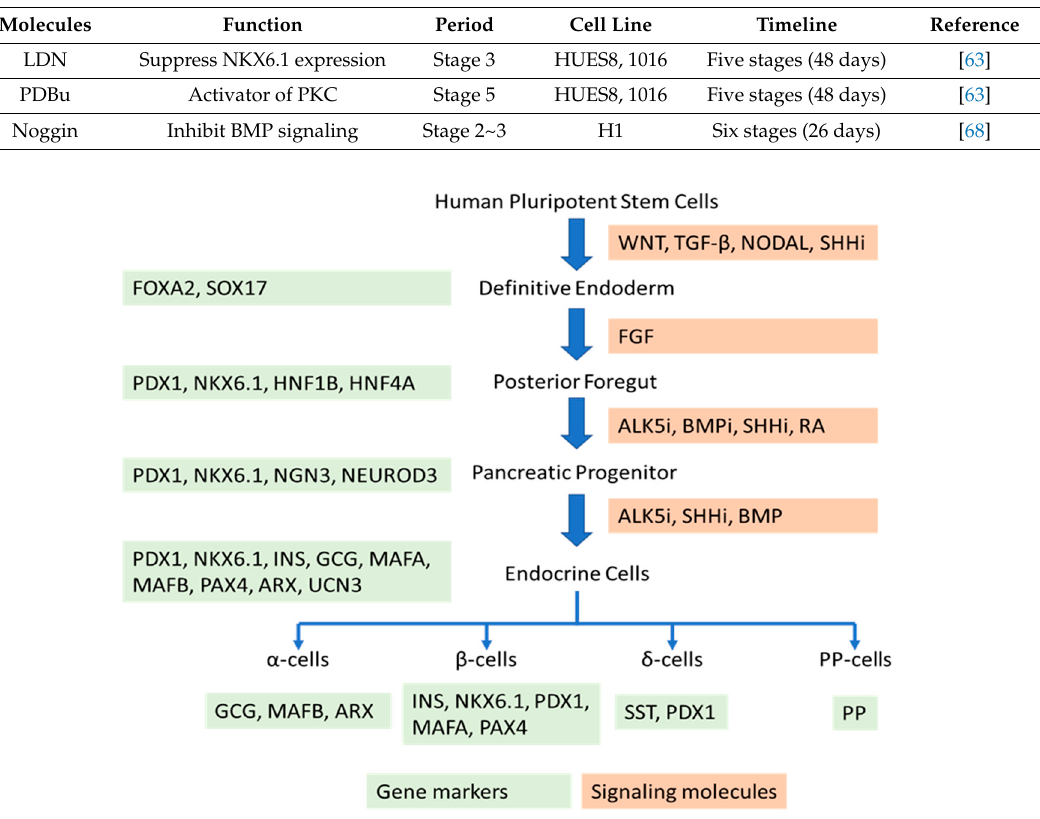
Figure 2. Key signaling molecules (in orange) and marker genes (in green) during the progression of human pluripotent stem cells (hPSCs) to pancreatic endocrine. BMPi: Bone morphogenetic protein inhibitor, ALK5i: ALK5 inhibitor, SHHi: Sonic hedgehog inhibitor.